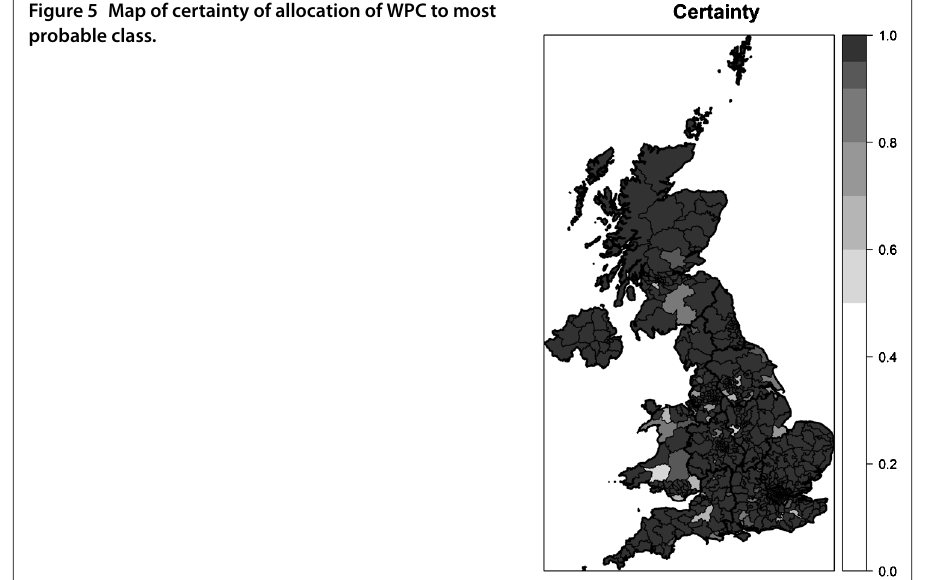
Figure 5 Map of certainty of allocation of WPC to most probable